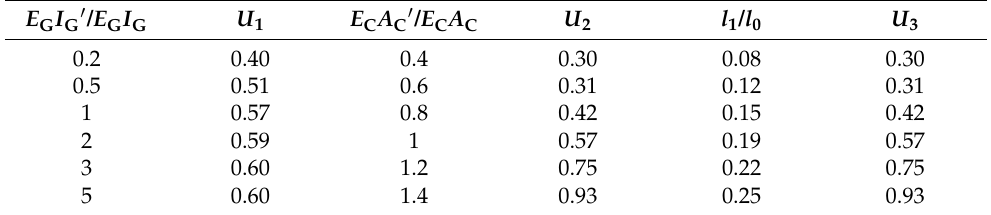
Table 5. Comprehensive evaluation value.